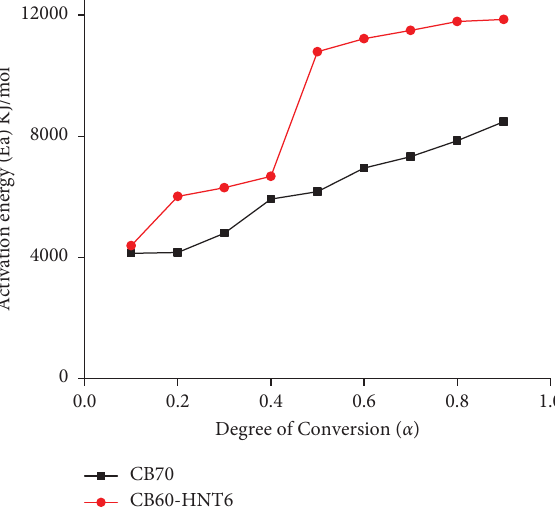
Figure 11: Activation esnergy vs. conversion degree ( α ).